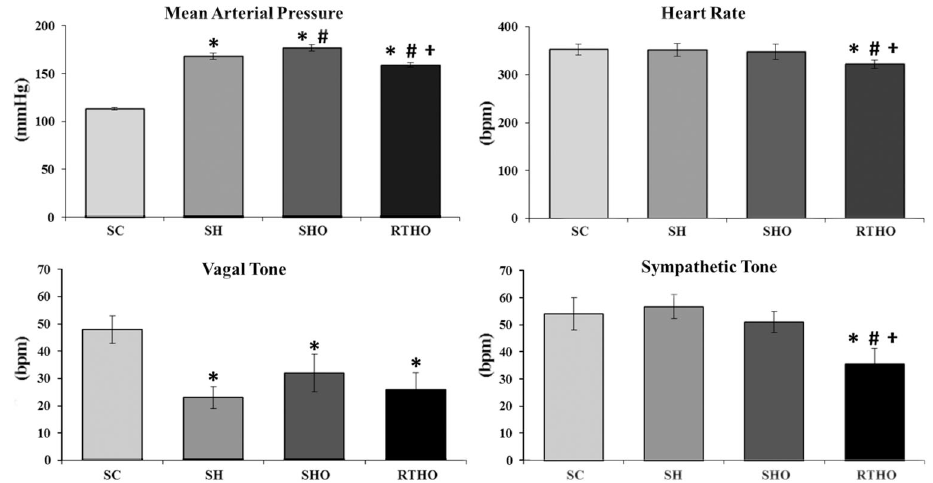
Figure 1. Hemodynamic and cardiac autonomic control in the studied groups. SC: sedentary control; SH: sedentary hypertensive; SHO: sedentary hypertensive ovariectomized; RTHO: resistance-trained hypertensive ovariectomized. *P , 0.05 vs SC; # P , 0.05 vs SH; + P , 0.05 vs SHO (one-way ANOVA, followed by Student-Newmann-Keuls